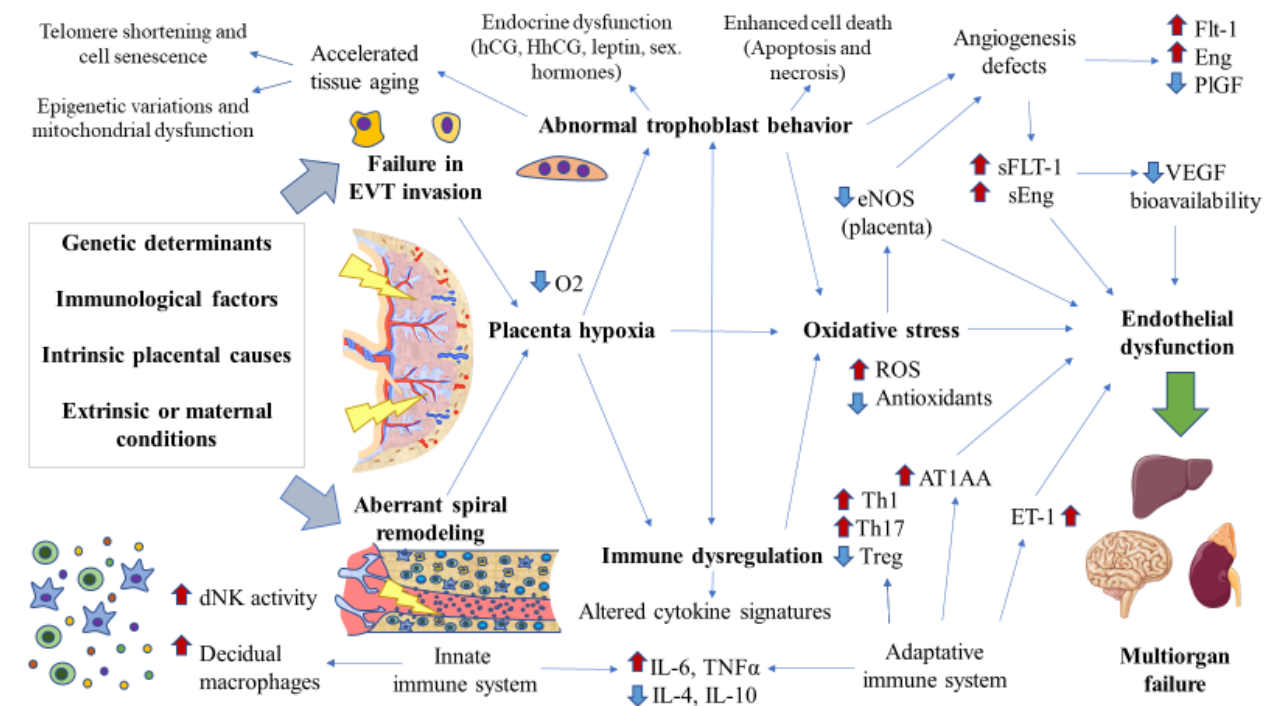
Figure 2. An overview of the main mechanisms involved in the pathogenesis of early-onset preeclampsia. As described before, aberrant spiral artery remodeling and failures in trophoblast invasion trigger placental hypoxia, leading to an exacerbated immune response affecting the innate and adaptative immune systems and cytokine production. In turn, an abnormal trophoblast behavior is also observed in the placenta, including accelerated aging, endocrine dysfunction, enhanced cell death, and angiogenesis defects, emphasizing the relevance of an imbalance between anti-angiogenic (sflt-1 and sEng) and pro-angiogenic factors (VEGF and PlGF). Almost every cell type in the placenta increases ROS production and decreases antioxidants, which are associated with oxidative stress, affecting some crucial components in the placenta, such as endothelial nitric oxide synthase, with detrimental effects on angiogenesis. Overall, oxidative stress, trophoblast alterations, and the inflammatory environment lead to systemic and profound endothelial dysfunction, eventually affecting different organs in the body and leading to the onset of clinical